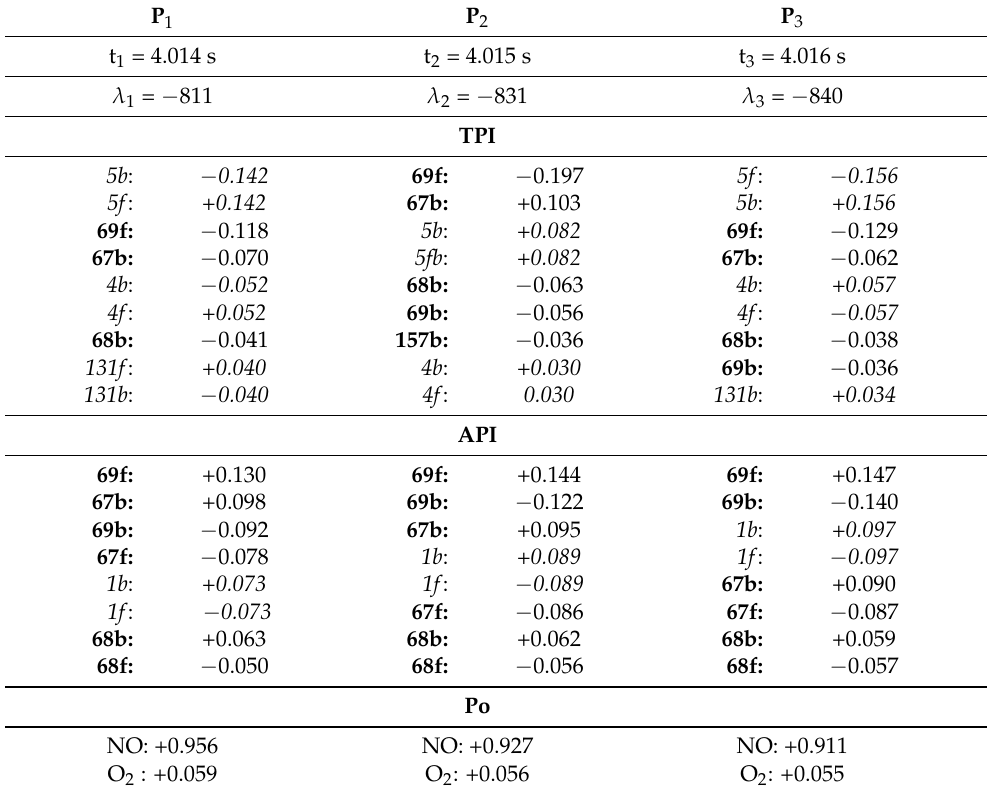
Table 4. The largest TPI, API and Po for the slow mode that points to NO in the mixture of NH 3 /air with 10%H 2 O for the points shown in Figure 3; Contributions larger than 5% are shown. P 1 P 2 P